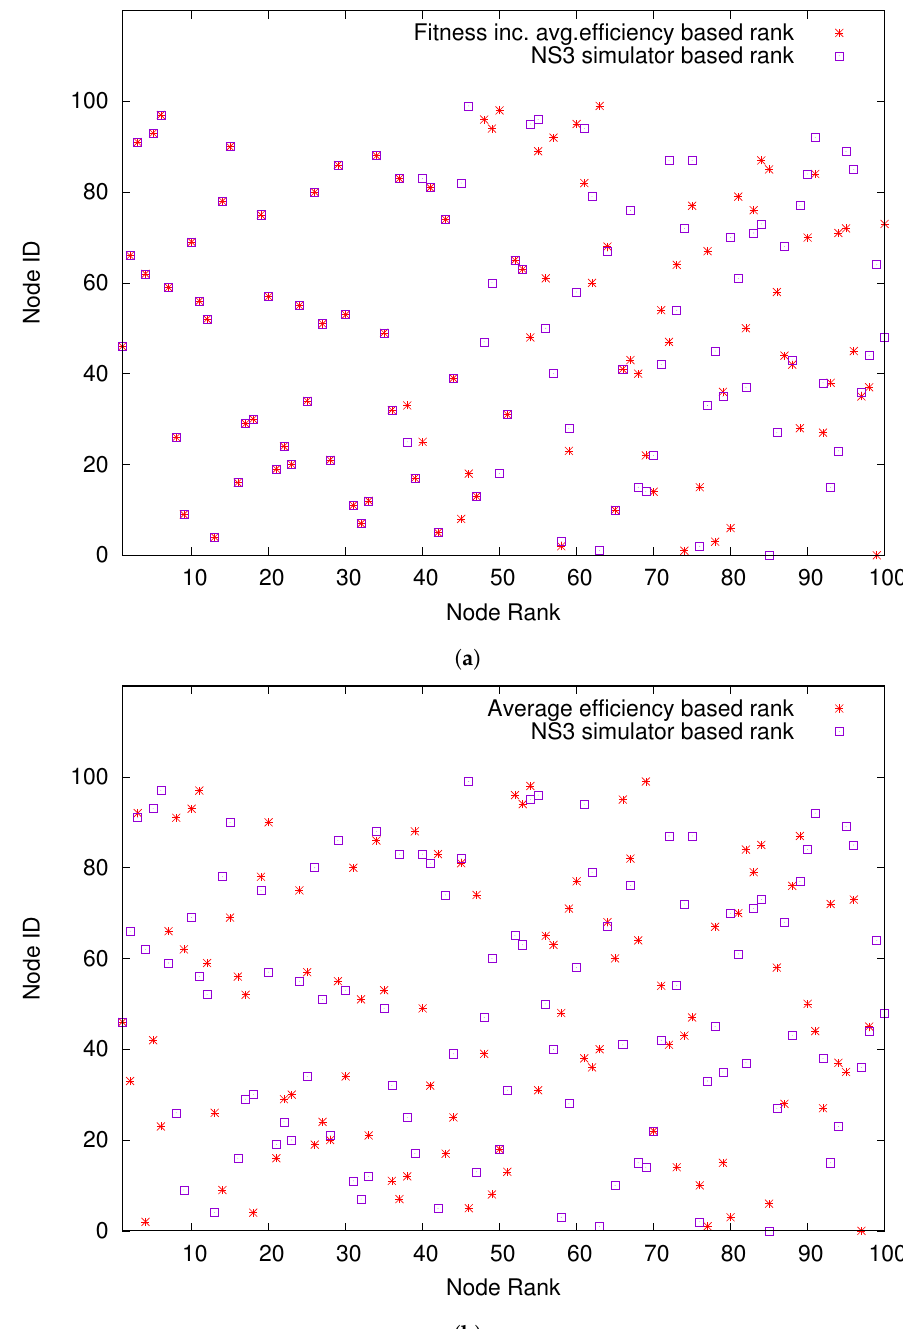
Figure A1. Node ranking comparison for random topology, when the fitness distribution correlates with the degree. ( a ) Fitness incorporated average efficiency-based ranking vs. NS3 simulator ranking. ( b ) Average efficiency-based ranking vs. NS3 simulator-based